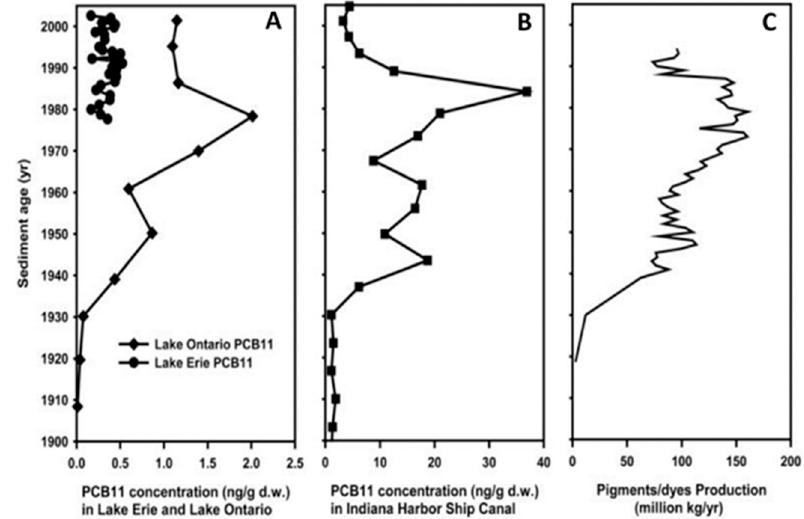
Figure 3. PCB11 concentration trends in sediment from ( A ) Lake Erie and Lake Ontario, and ( B ) Indiana Harbor ship canal reflect the production history of pigments/dyes production in the United States ( C ). Figure adopted from Hu and colleagues [21]. Copyright PMC 2011.